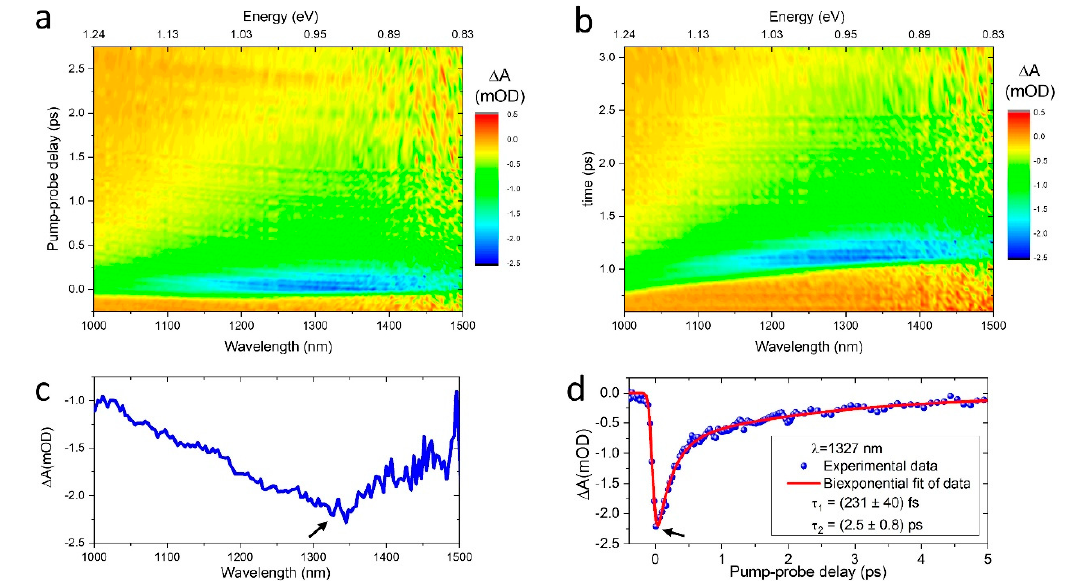
Figure 4. 2D spectrograph of time resolved absorbance change in single layer graphene (SLG) with pump energy of 1.08 eV at a fluence of 180 µJ/cm 2 ( a ) after the numerical procedure of chirp correction and ( b ) before chirp correction. ( c ) Di ff erential spectra ∆ A of corrected dataset at maximum bleach. ( d ) Time resolved di ff erential absorbance ∆ A at red-shifted probe energy of 0.934 eV (1327 nm). The blue circles represent the experimental results and the red line is a biexponential fit of the data with the two decay constants reported in the inset.